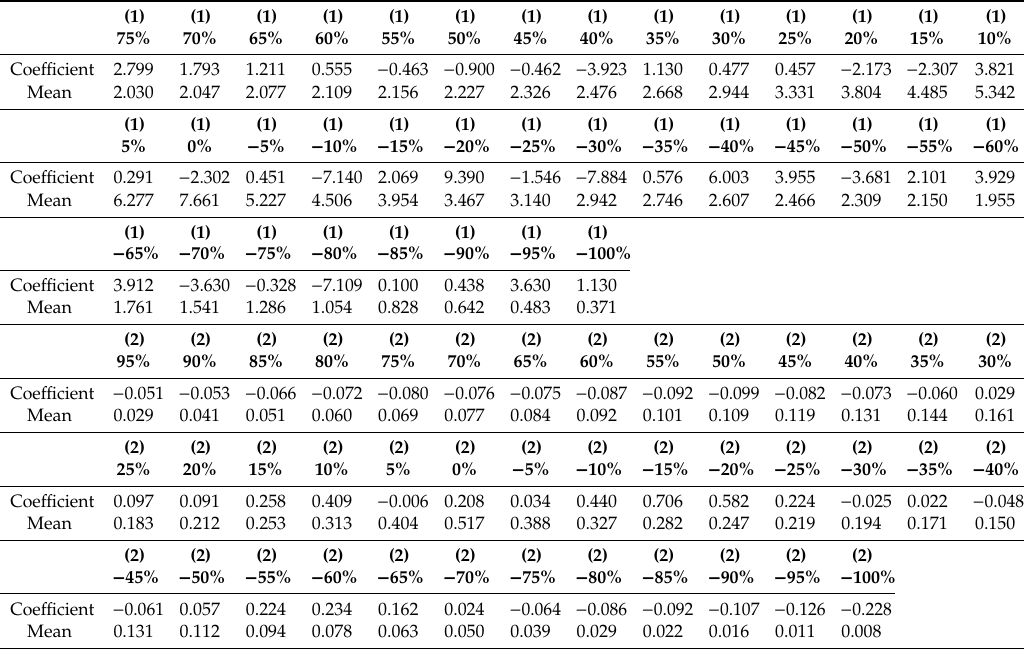
Table A1. Proposed systolic blood pressure estimation